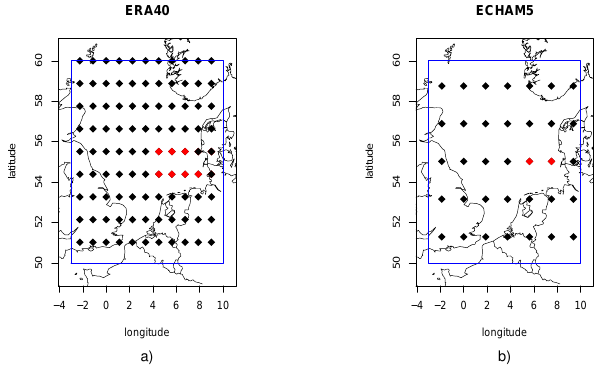
Figure 1. (a) German Bight (red dots) and North Sea region (black dots) for ERA-40 reanalysis. (b) German Bight (red dots) and North Sea region (black dots) for ECHAM5 (T63) data. The blue box de- fines the boundaries of the North Sea